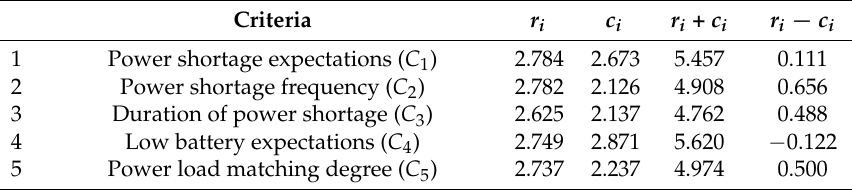
Table 4. Sum of influences given and received on